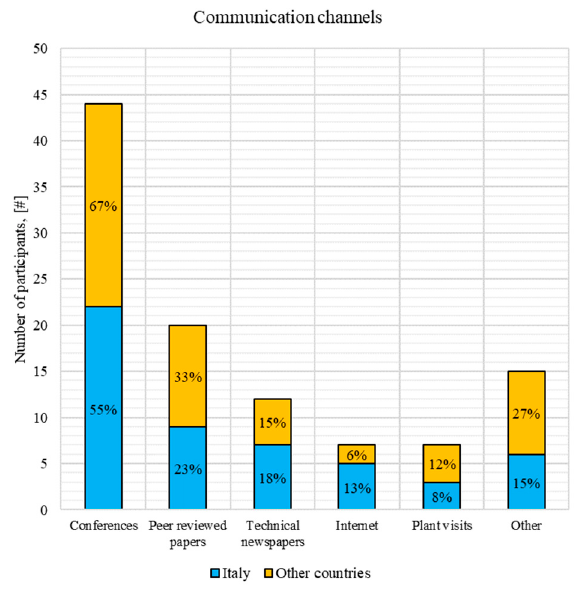
Figure 10. LTDH communication channels.